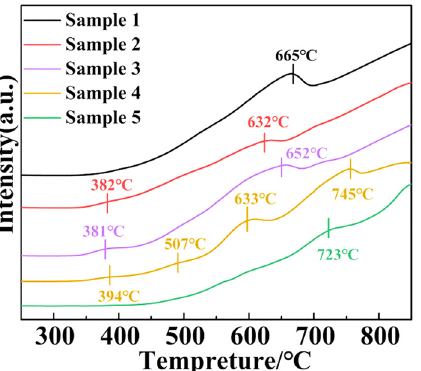
Figure 10: Methane combustion with time - on - stream for samples 1, 3, and